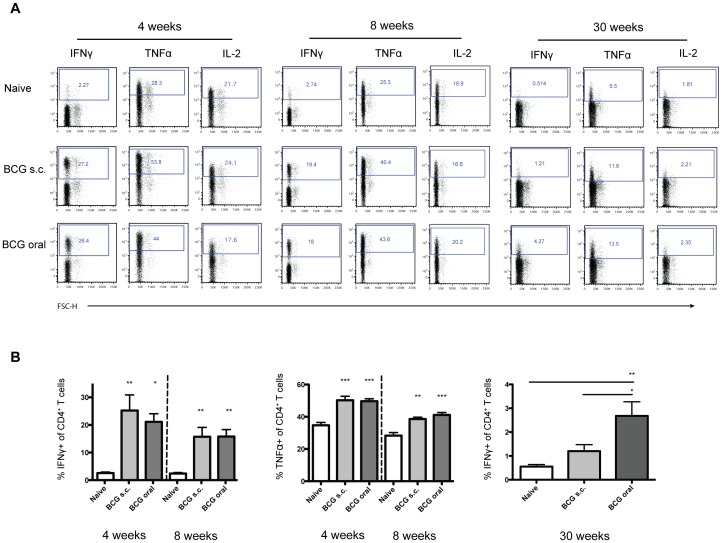
Oral vaccination with Liporale™-BCG induces CD4+ T cell cytokine production in the lung.Lymphocytes from the lungs of naïve, Liporale™-BCG vaccinated (BCG oral) or subcutaneous vaccinated (BCG s.c.) mice were stimulated for 6 hours in vitro in the presence of Brefeldin A and monensin then analyzed by flow cytometry. (A) Representative plots show CD4+ T cells from the lungs of naïve or BCG vaccinated mice expressing IFNγ, TNFα or IL-2. (B) Bar graphs show the percentage of CD4+ T cells from the lungs of naïve or BCG vaccinated mice expressing cytokines at 4, 8 or 30 weeks post immunization. Results are displayed as mean + SEM of n = 5 for each group, significance expressed relative to naïve: *p<0.05, **p<0.01, ***p<0.001 (one way ANOVA with Tukey post test). Eight and 30 weeks results are representative of 2 independent experiments.